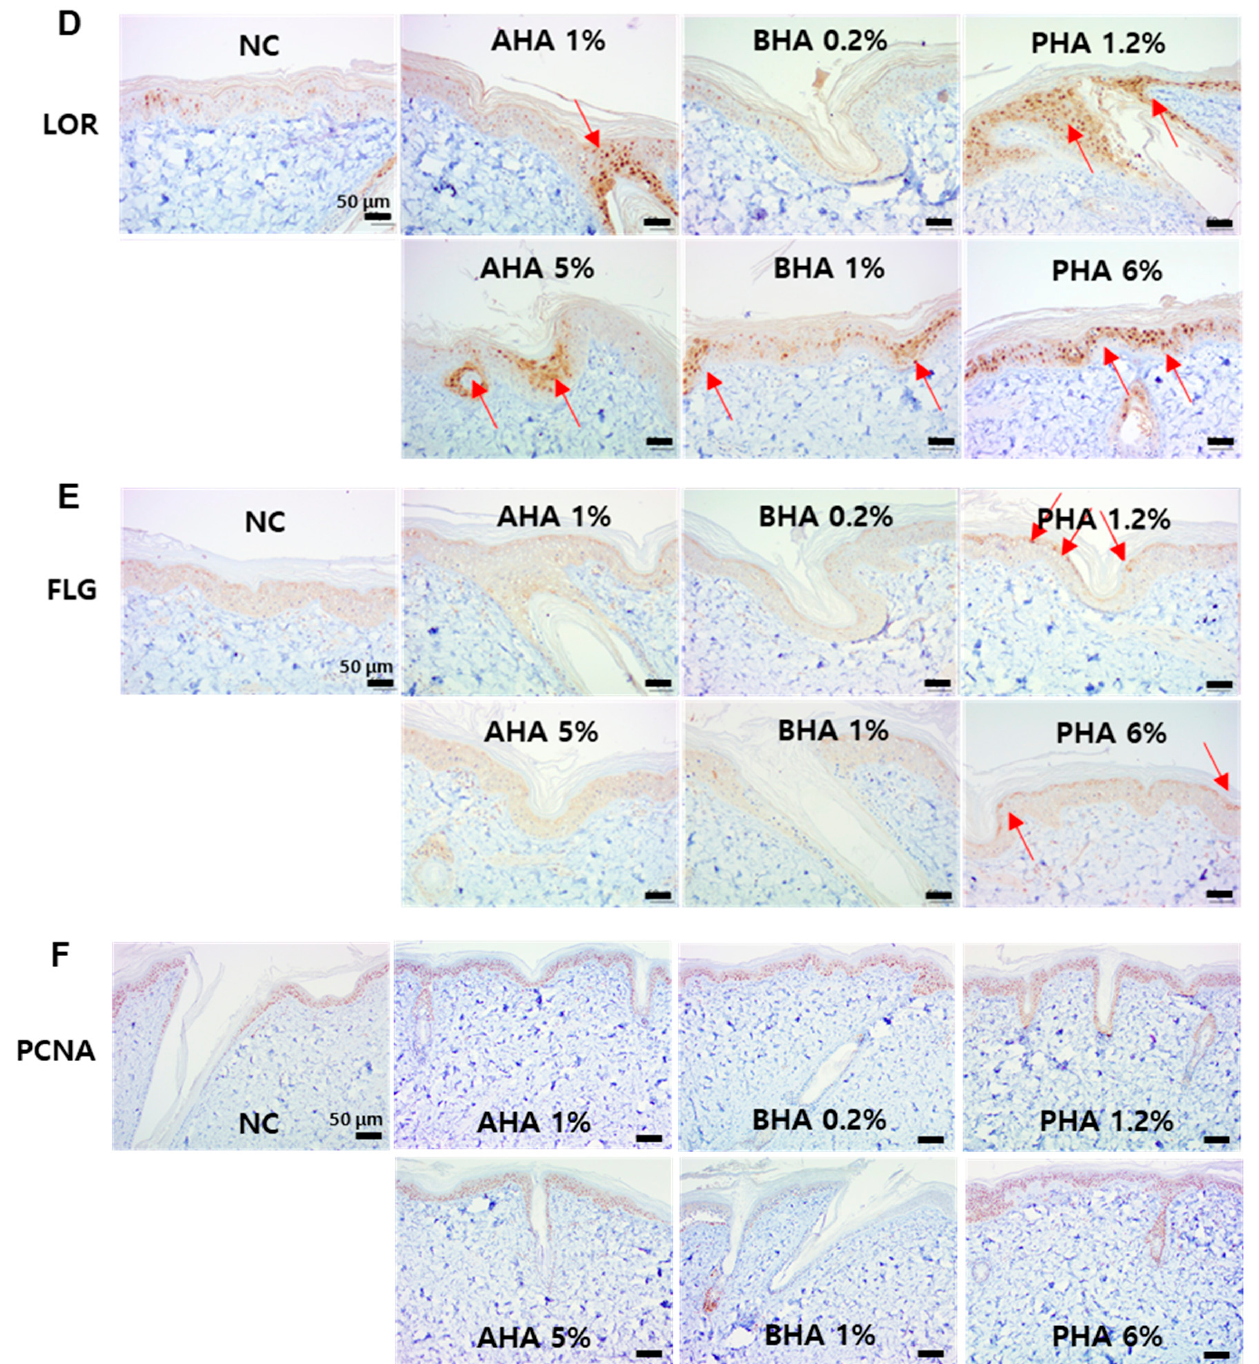
Figure 6. Immunohistochemical staining of key protein components of the skin epidermis Immunohistochemical images of ex vivo porcine skin with antibodies against ( A ) K5, ( B ) K1, ( C ) K10, ( D ) LOR, ( E ) FLG, and ( F ) PCNA. K1: Keratin 1, K5: Keratin 5, K10: Keratin 10, LOR: loricrin, FLG: filaggrin, PCNA: proliferating cell nuclear antigen. The regions in which the expression of the specific protein is significantly higher than the negative control are indicated by red arrows. All scale bar represents 50 μ m.